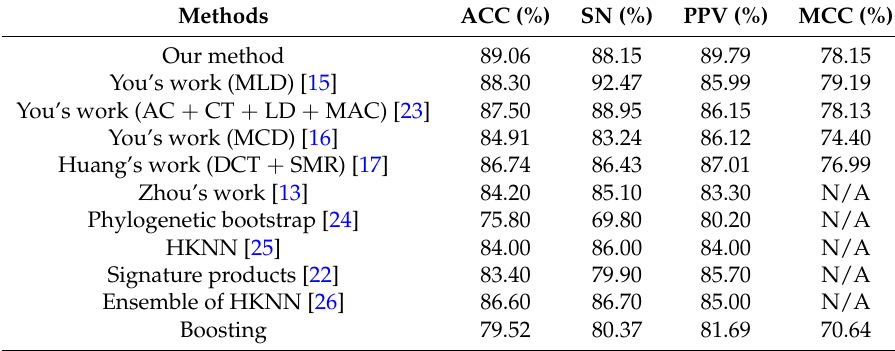
Table 4. Comparison of the prediction performance between our proposed method and other methods on the H . pylori dataset. N/A means not available.